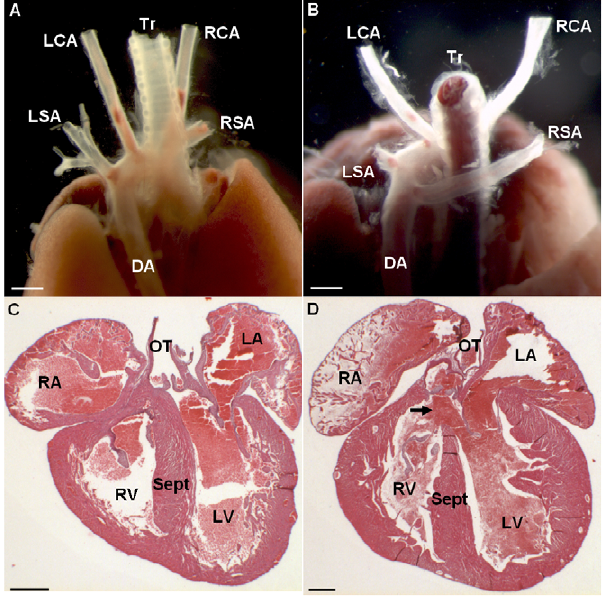
Figure 1. Changes in cardiovascular morphology observed in the Ts65Dn model. Posterior view of a wt individual illustrates the normal location of the aorta and efferent vessels (A). Posterior view of a Ts65Dn individual shows an aberrant right subclavian artery (RSA) arising from the distal part of the aortic arch and describing a retro- oesophagian loop (B). Haematoxylin-eosin staining of histological cross- sections illustrates full septation of the ventricles with individualized valves in wt (C) while Ts65Dn heart cross-section shows an upper communication of the ventricles (D; arrow). This cardiovascular anomaly was observed in 1 in 18 Ts65Dn dead newborns. LSA, left subclavian artery; RSA, right subclavian artery; DA, descending aorta; RA, right atrium; LA, left atrium; RV, right ventricle; LV, left ventricle; Sept, septum; OT, outflow tract. Scale bars represent 1 mm in A, B and 400 m m in